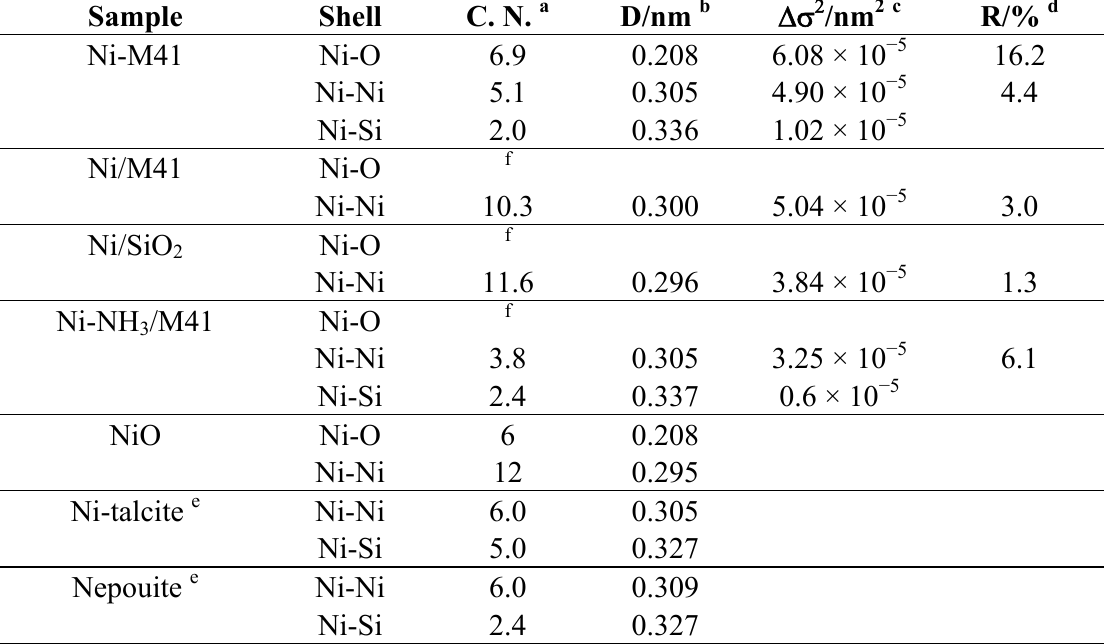
Table 1. XAFS parameters of Ni ion in various Ni-loaded silica